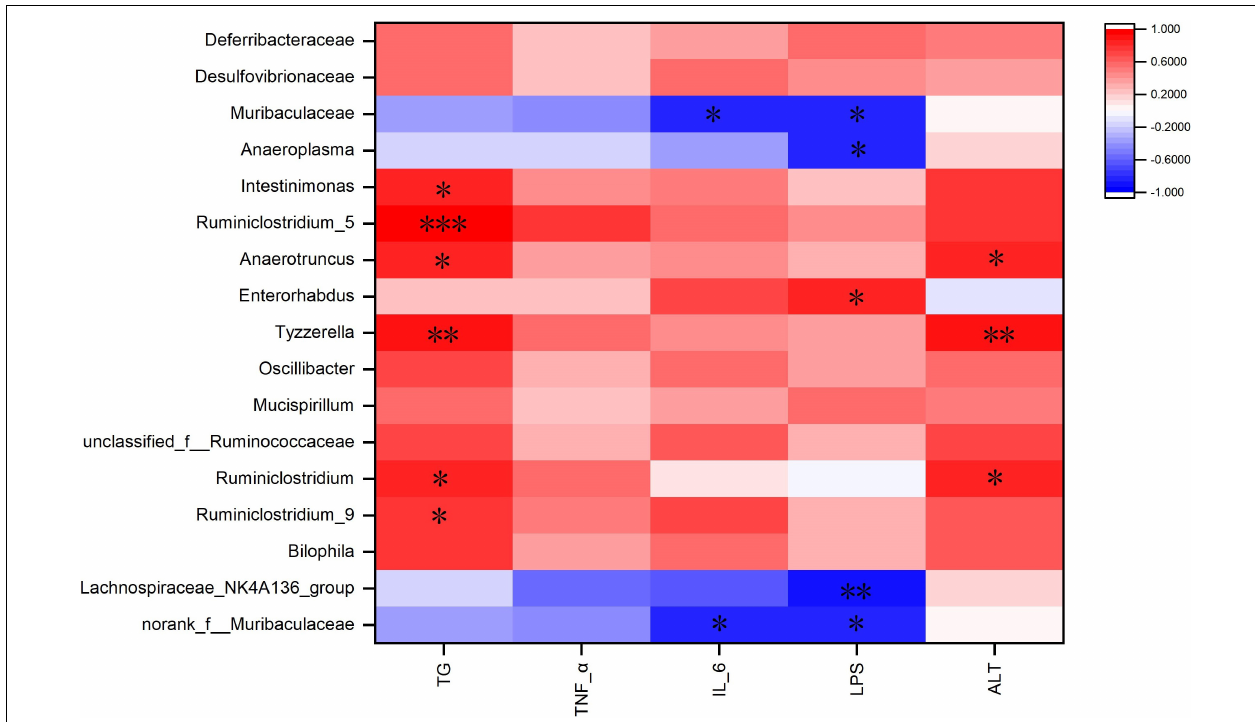
and IL-6 (16). Adzuki bean extract containing